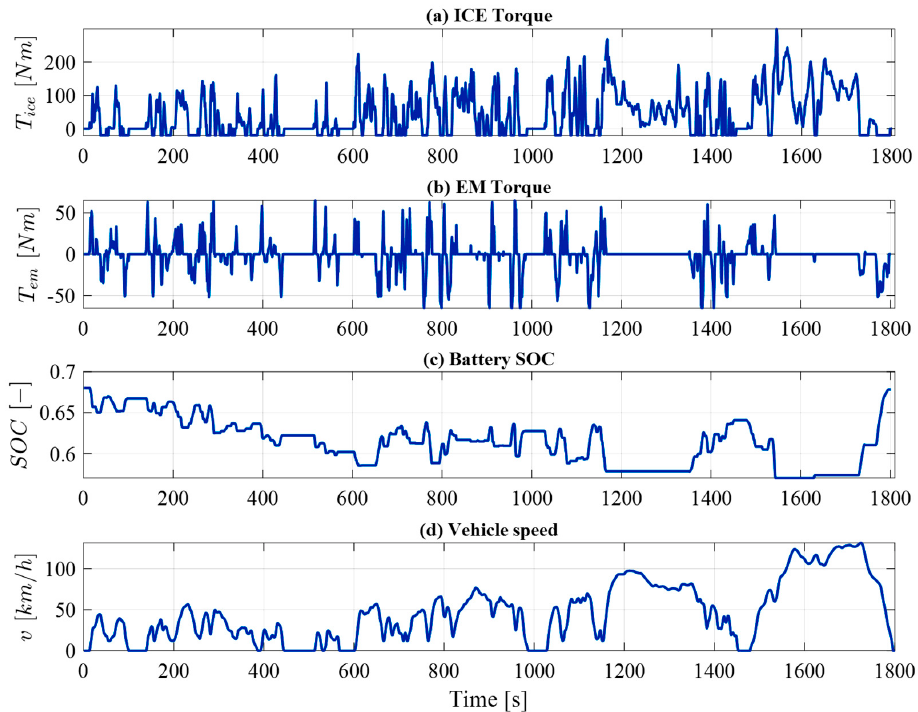
Figure 21. Simulation results with no thermal limitations for WLTC driving cycle: ( a ) ICE torque, ( b ) EM torque, ( c ) Battery SOC, ( d ) Vehicle speed.